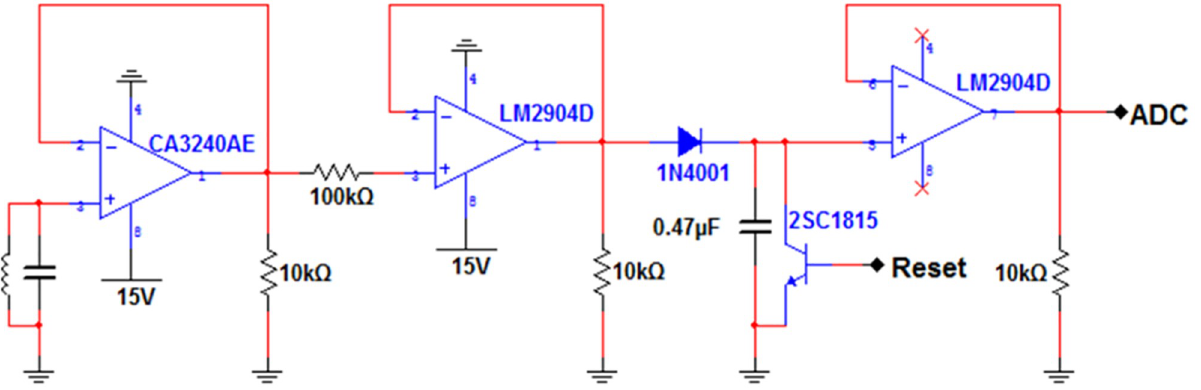
Fig 7. Schematic diagram of additional circuit for induced resonance. The inductor symbol in the left OPAMP part of the drawing refers to the coil placed in the chest model, and the capacitor is a capacitor whose target resonance frequency is 34 kHz. The remainder on the right is the peak hold detector